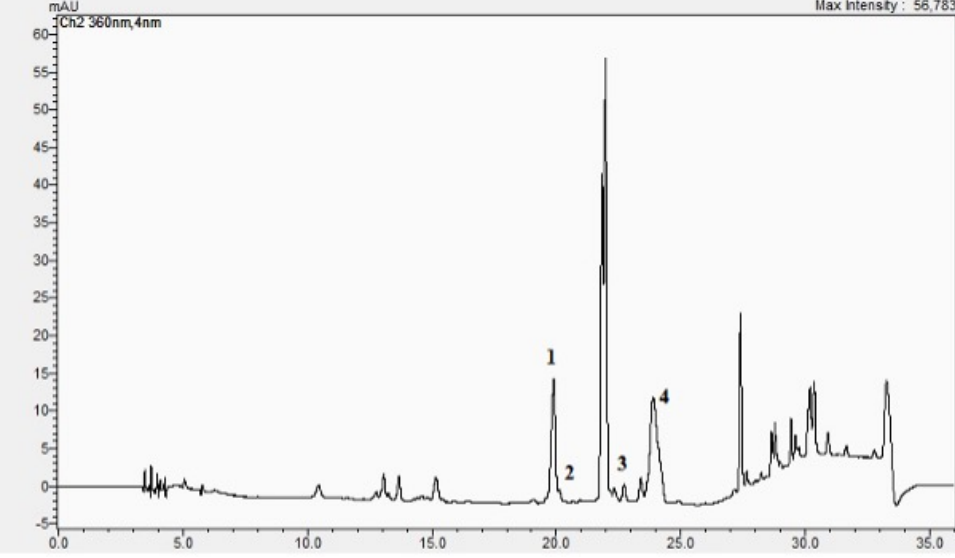
Figure 1. The HPLC chromatogram of BC-GTE. 1 = quercetine, 2 = luteolin, 3 = kaempferol, 4 = apigenin. 2.2. The BC-GTE Does Not Feature Cytotoxicity in the Case of Drosophila melanogaster